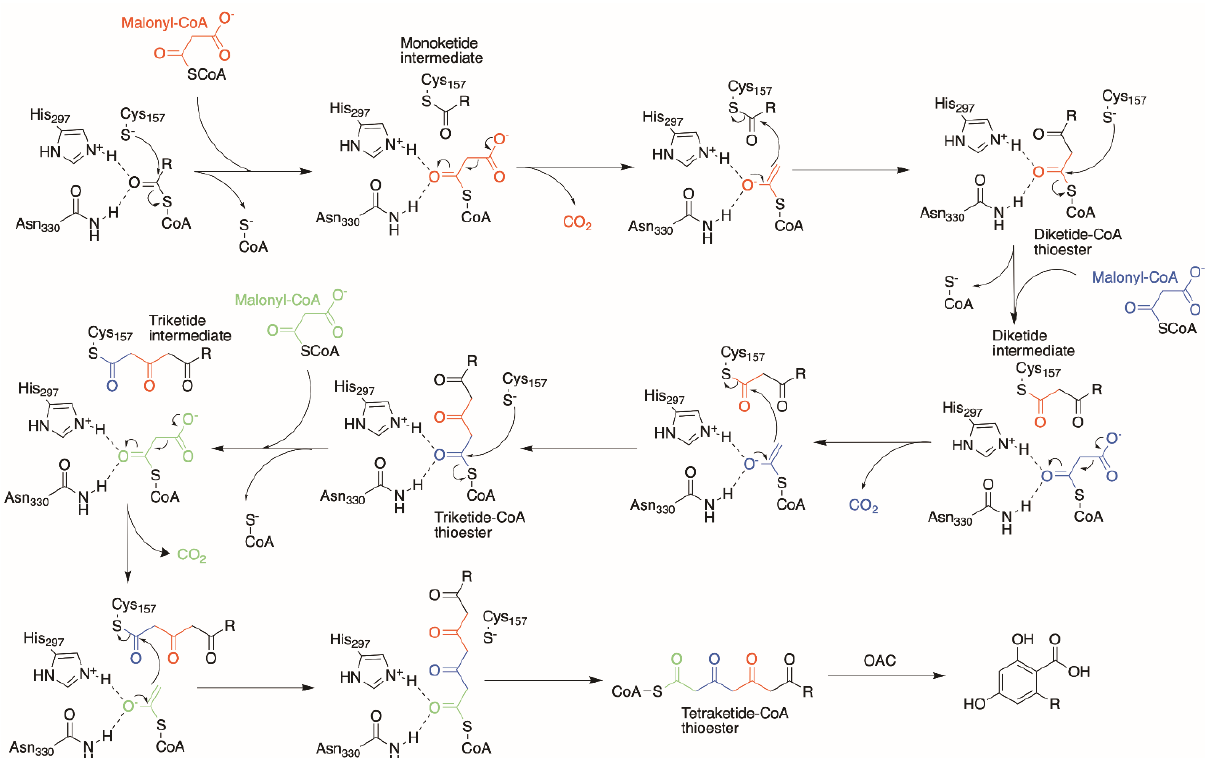
Figure 3. Proposed OLS mechanism forming a tetraketide-CoA thioester product for OAC to cyclize into a resorcinolic ring such as OLA.